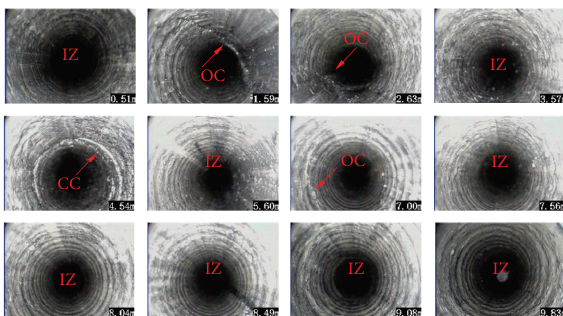
Figure 16: Borehole imaging results of roof (OC means open crack; CC means circumferential crack; IZ means intact